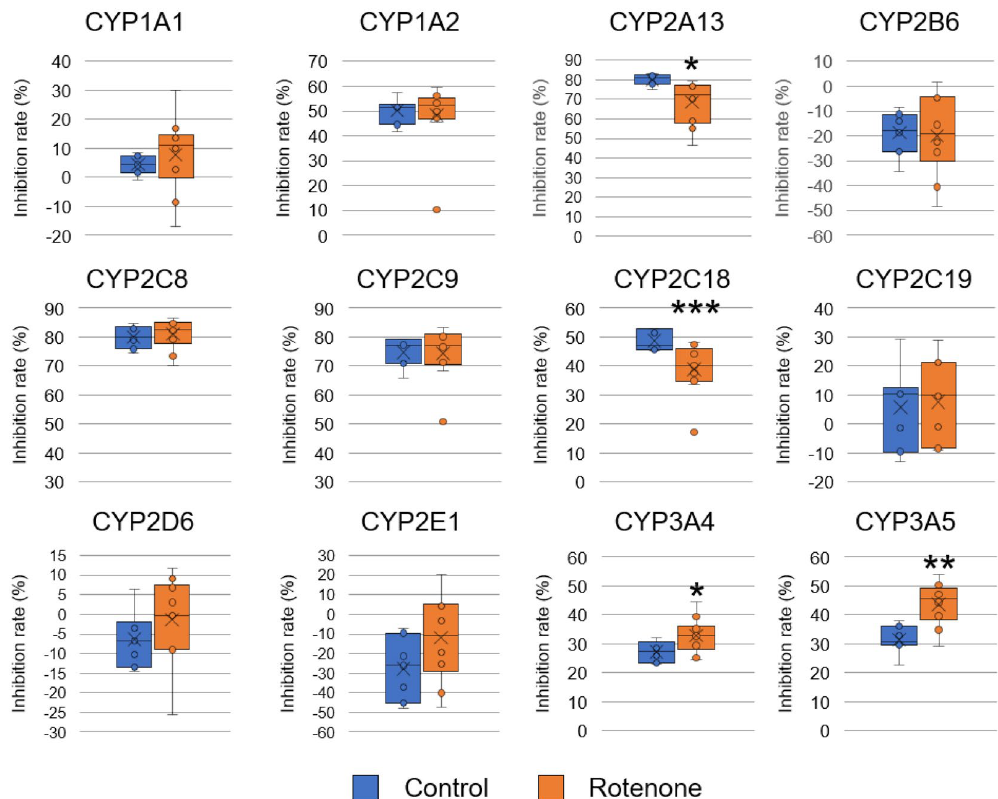
Figure 3. P450 inhibition assay using serum samples of Parkinson’s disease model rats. Inhibition rate of reactions in the sera recovered from control rats (n = 7) and rotenone-administered rats (n = 10) toward 12 types of P450s and fluorescent substrate reactions are presented. Values are presented in a box plot. The black solid bars within the box plot represent the median abundance, and the cross mark represents mean abundance. Significant differences were evaluated via Welch’s t-test (*** P < 0.001, ** P < 0.01, * P <